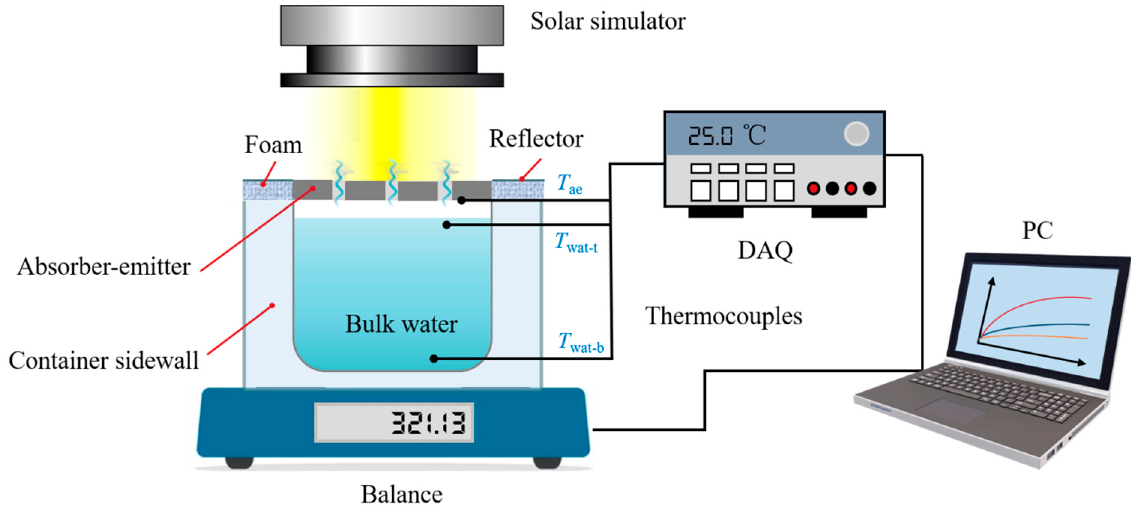
Figure 4. Schematic diagram of the test rig for laboratory